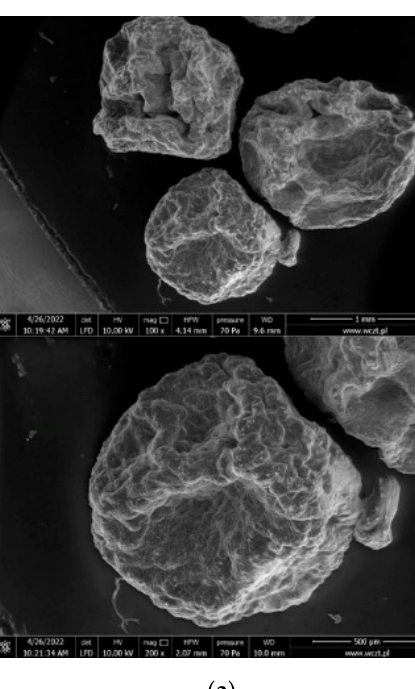
Figure 5. Scanning electron micrographs of alginate capsules without gemini surfactant: ( a ) Al@empty; ( b ) Al@empty+BaSO 4.